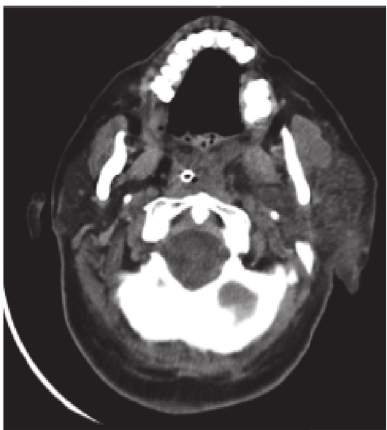
Figure 1: Head CT demonstrating left parotiditis.